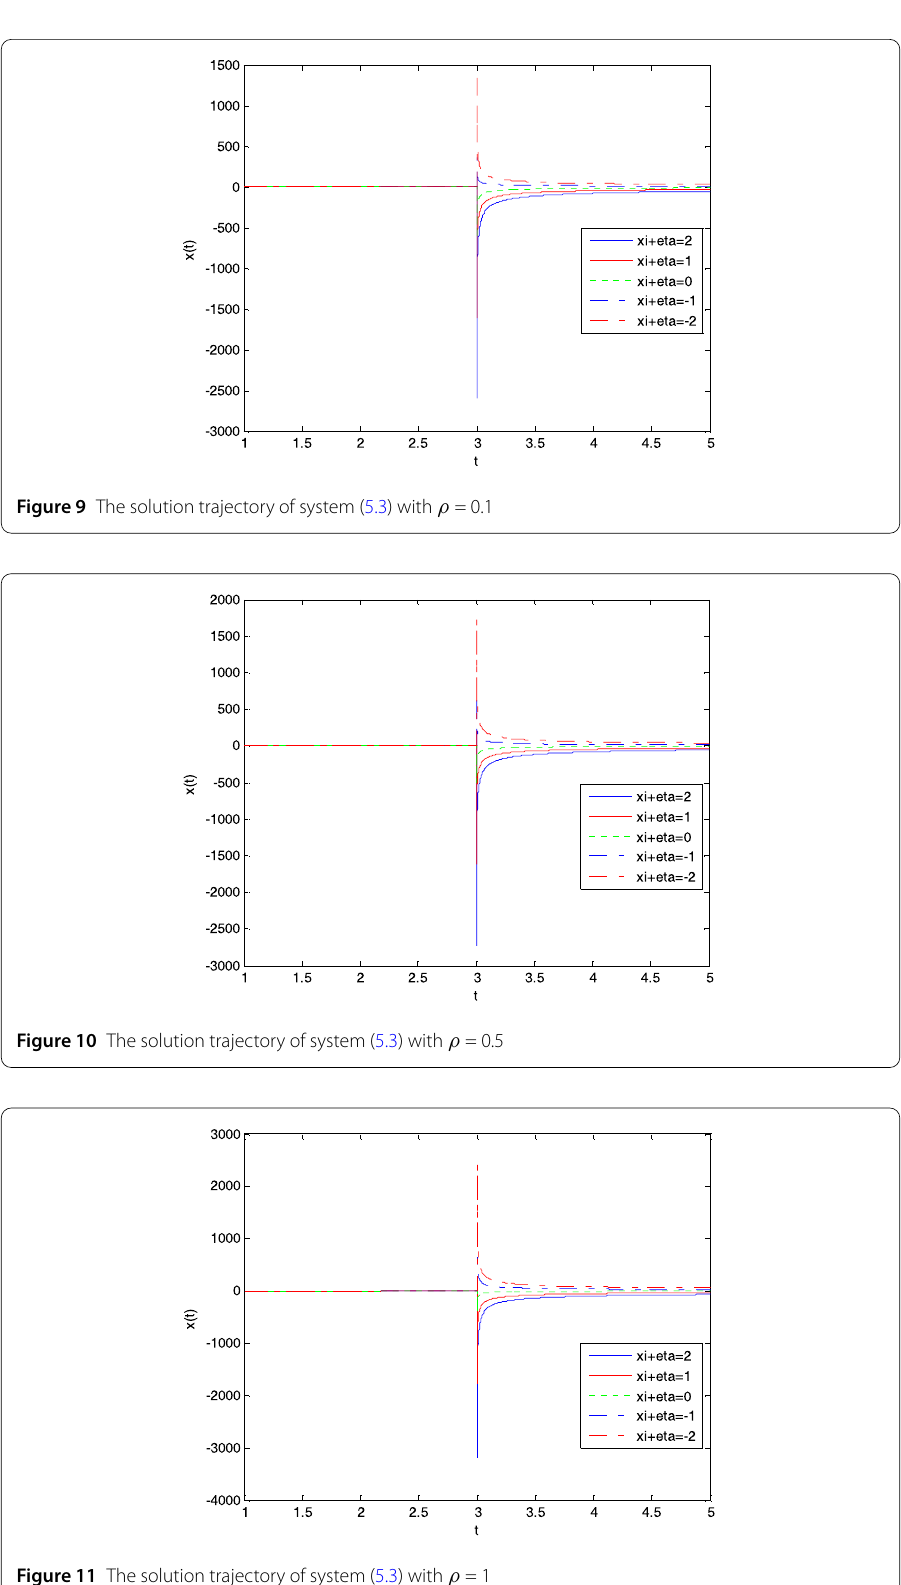
Figure 11 The solution trajectory of system (5.3) with ρ =